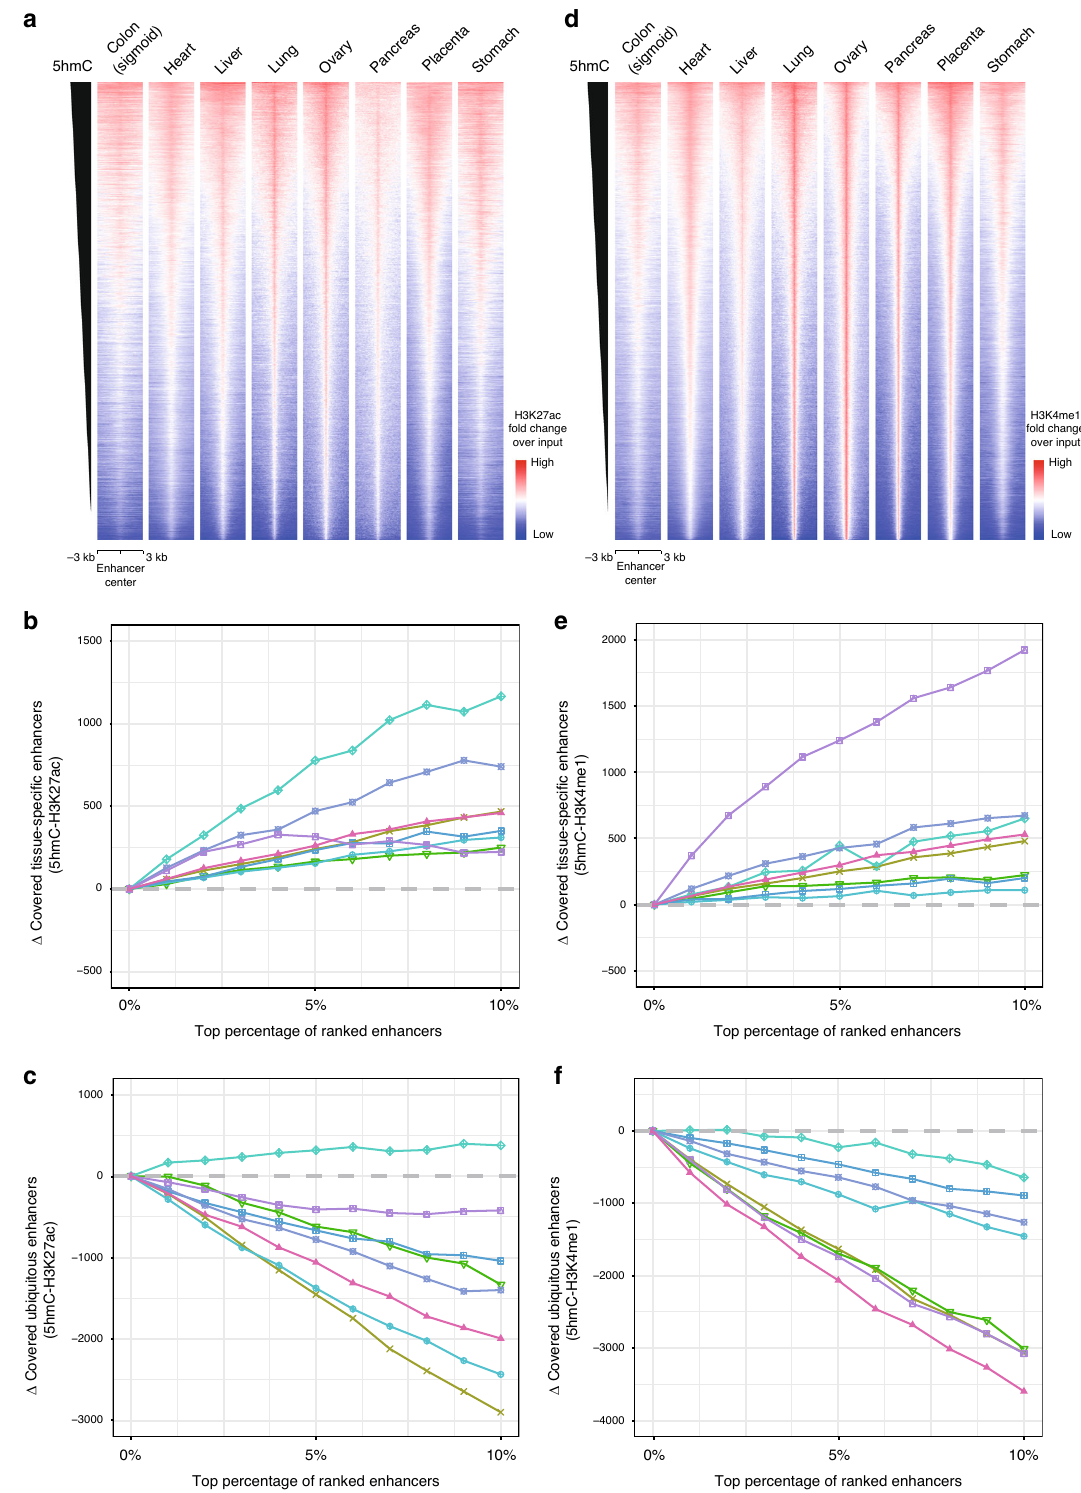
Fig. 4 Enrichment of 5hmC on tissue-speci fi c enhancers. a Heatmaps showing correlation of 5hmC and H3K27ac signals at all enhancers in 8 representative tissue types. b Subtractions of covered tissue-speci fi c enhancers for the top 10% 5hmC-modi fi ed enhancers and the top 10% H3K27ac- modi fi ed enhancers. c Subtractions of covered ubiquitous enhancers for the top 10% 5hmC-modi fi ed enhancers and the top 10% H3K27ac-modi fi ed enhancers. d Heatmaps showing correlation of 5hmC and H3K4me1 signals at all enhancers in 8 representative tissue types. e Subtractions of covered tissue-speci fi c enhancers for the top 10% 5hmC-modi fi ed enhancers and the top 10% H3K4me1-modi fi ed enhancers. f Subtractions of covered ubiquitous enhancers for the top 10% 5hmC-modi fi ed enhancers and the top 10% H3K4me1-modi fi ed